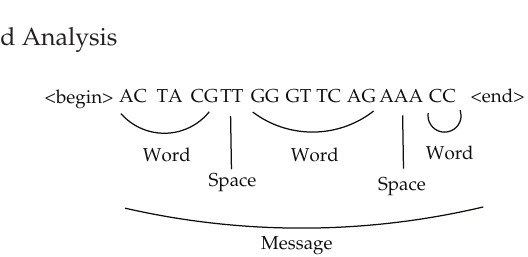
Figure 2: Example of a message when considering n (cid:7) 2, { TT, AA } ≡ “spaces”, { TC, TA, TG, CT, CC, CA, CG, AT, AC, AG, GT, GC, GA, GG } ≡ “word characters.” Multiple consecutive spaces are considered as a single